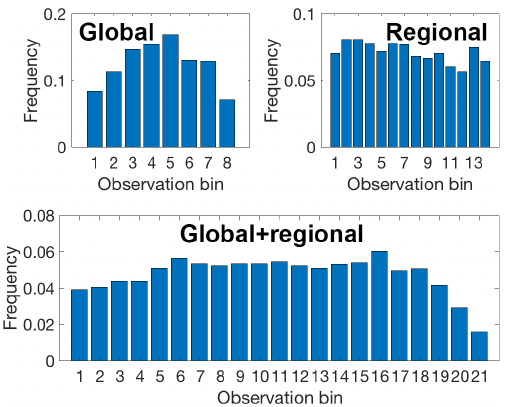
Figure 5. Talagrand diagrams of global models, regional models and the global + regional set of model results.